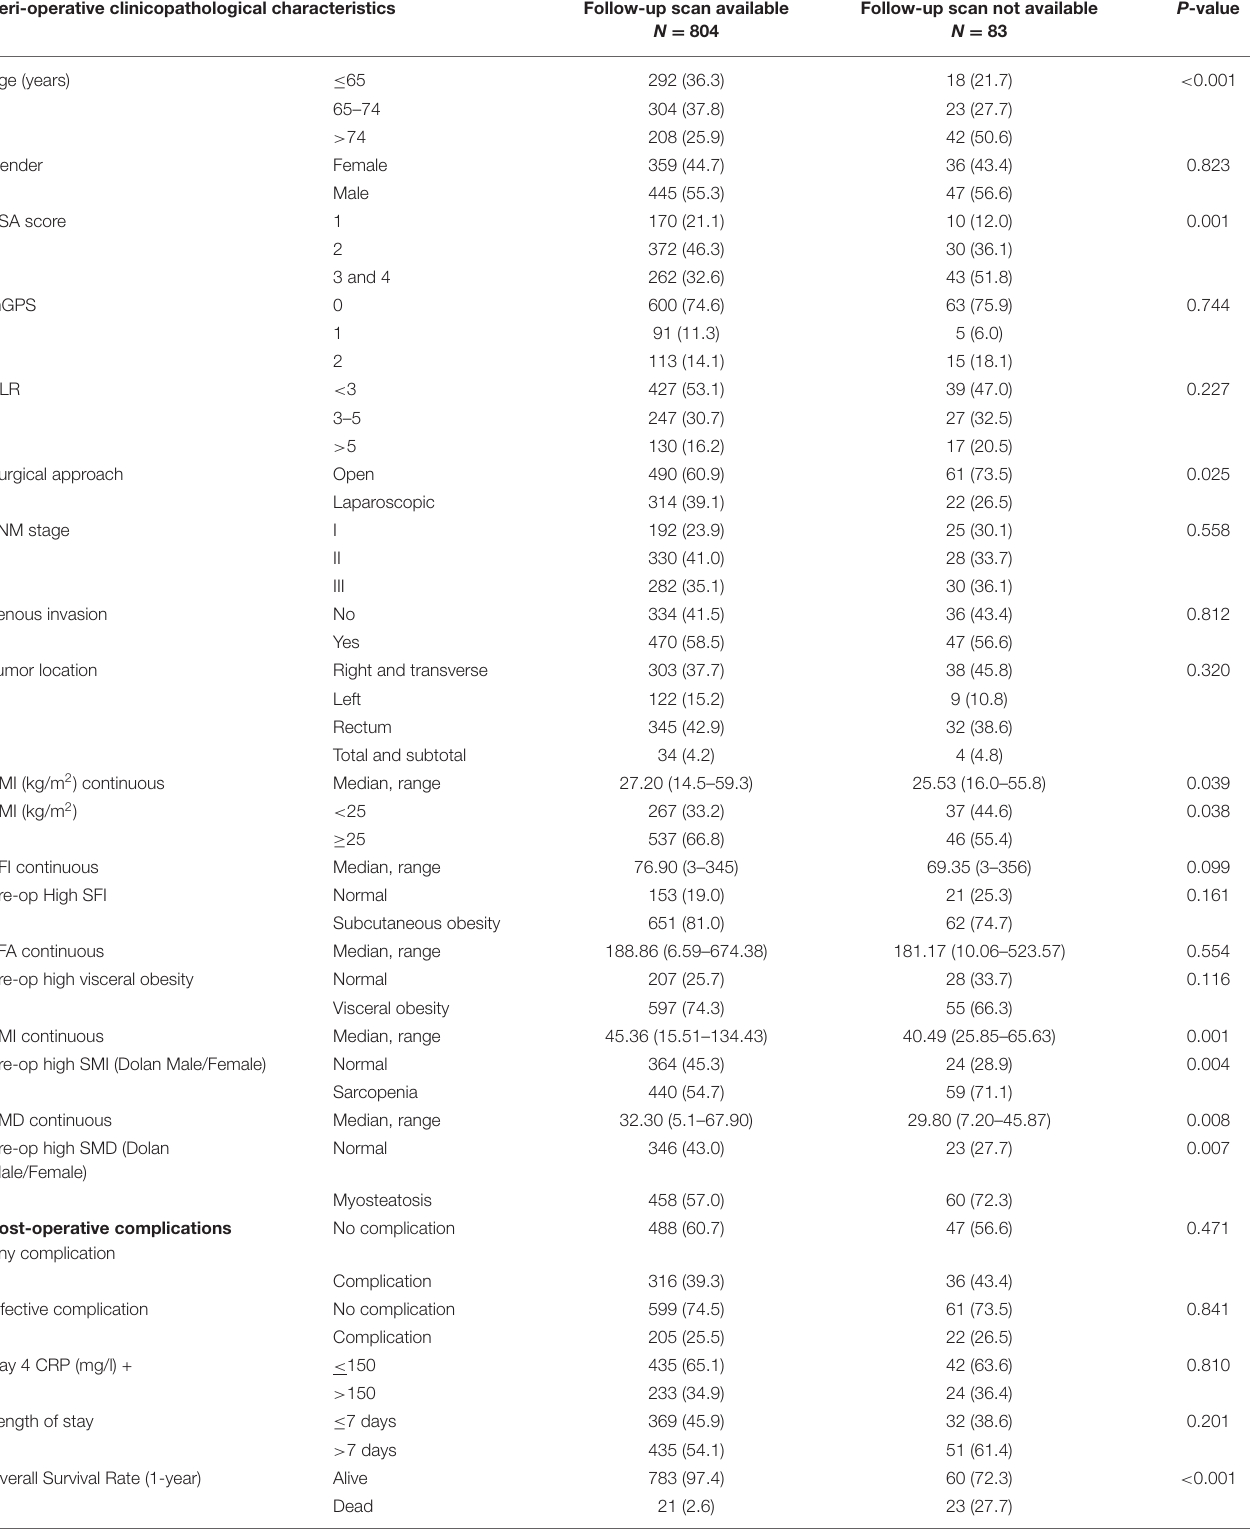
TABLE 1 | Clinicopathological characteristics of patients undergoing potentially curative resection for colorectal cancer with and without follow-up scans at 1